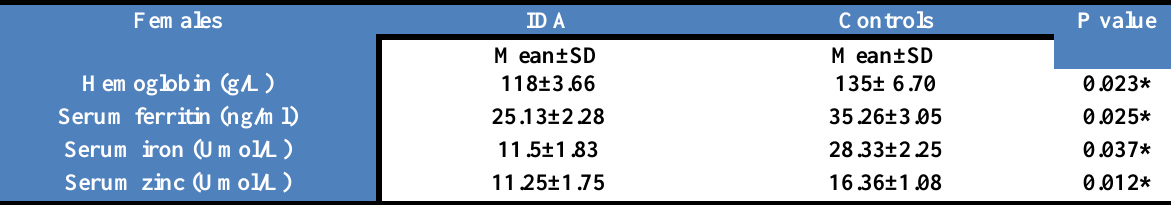
Table, 2: Some parameters for iron deficiency anemia without parasitic worms and control groups in females. Females